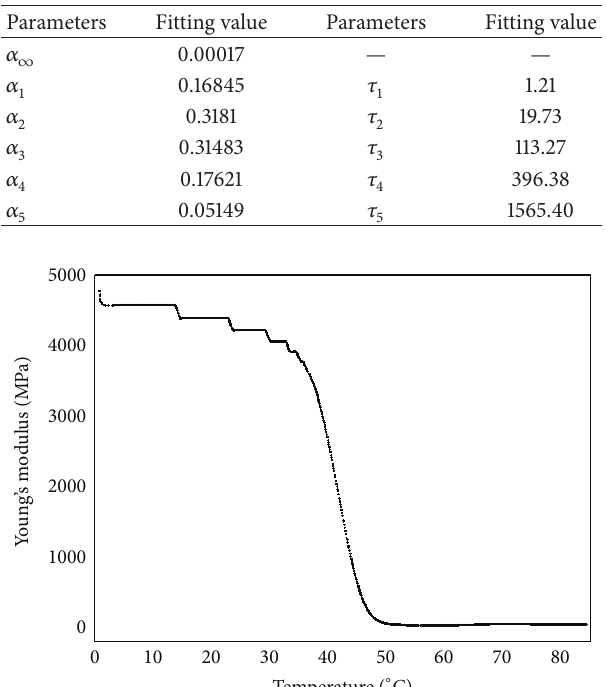
Table 1: The parameters of generalized Maxwell model.